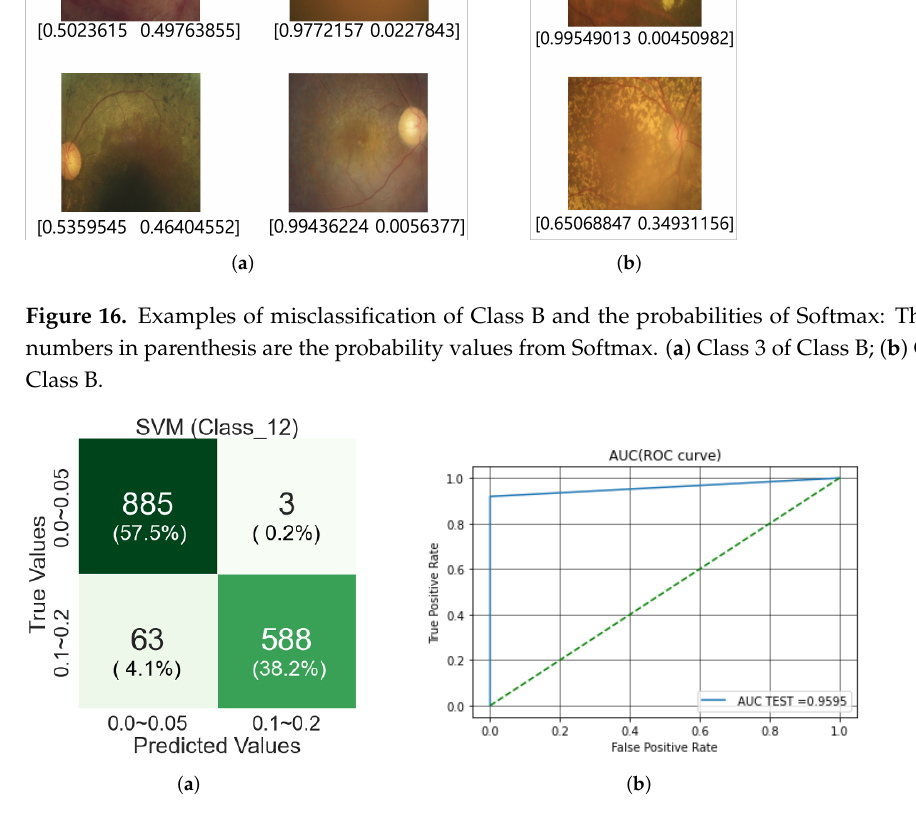
Figure 17. Validation results of SVM-RBF-Kernel classification for Step-2-1. ( a ) Confusion matrix; ( b ) AUC (ROC)